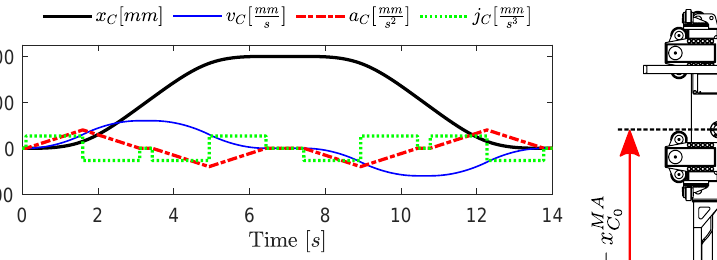
Figure 3: Main arm cylinder motion profile example.